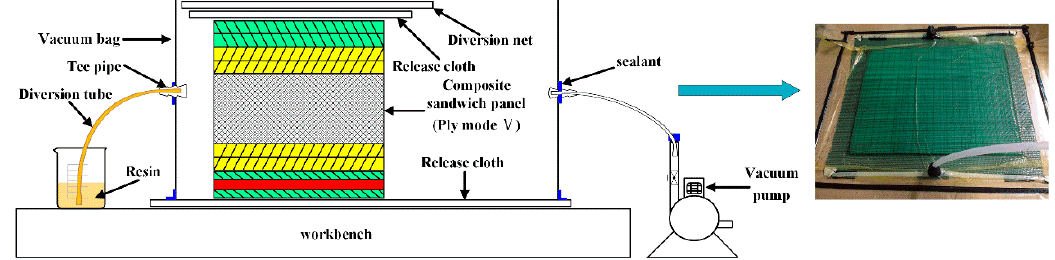
Figure 2. The schematic diagram of the VARI process.